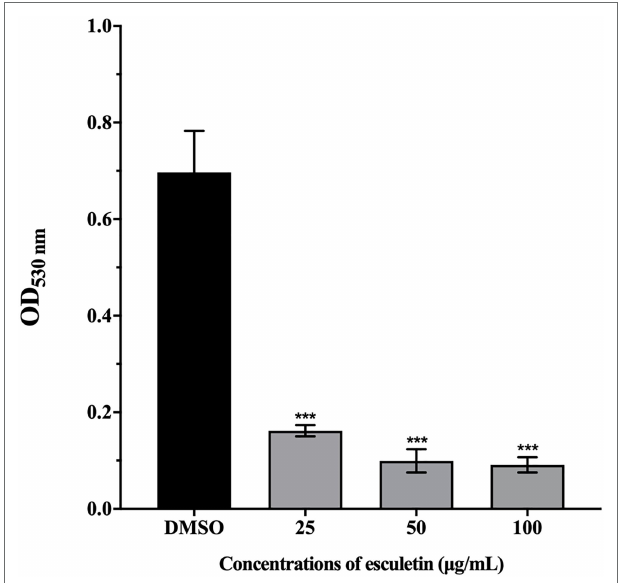
TABLE 1 | PCR primers for quantitative real-time PCR.